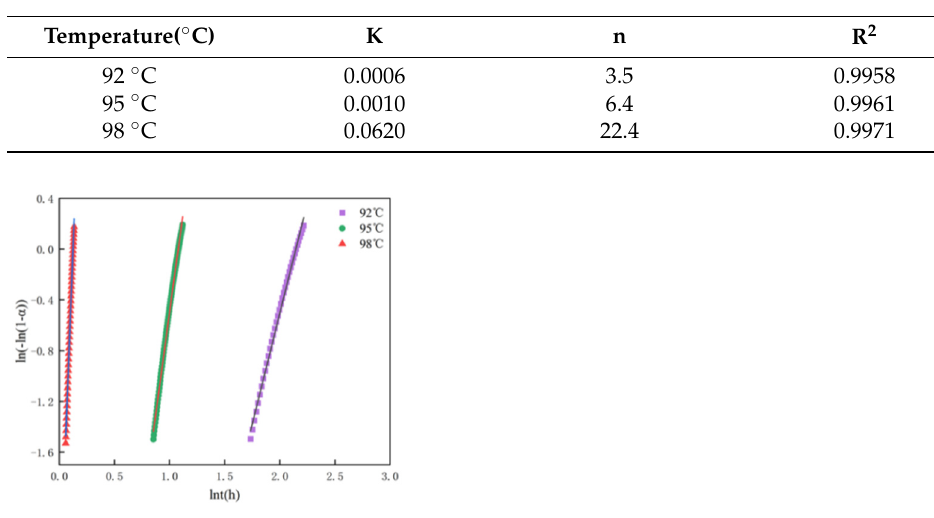
Table 3. Avrami-Erofeev kinetics parameters of α -HH samples synthesized at different hydrother- mal temperatures.